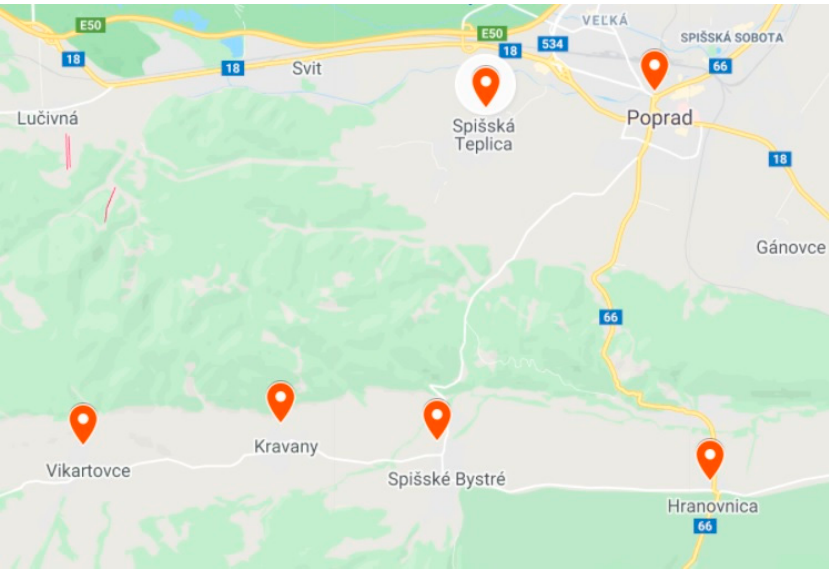
Figure 2. Data collection sites: integrated: Poprad, Spisska Teplica; separated: Vikartovce, Kravany; segregated: Hranovnica, Spisske Bystre. Source: Google Maps, 2021 and the authors.